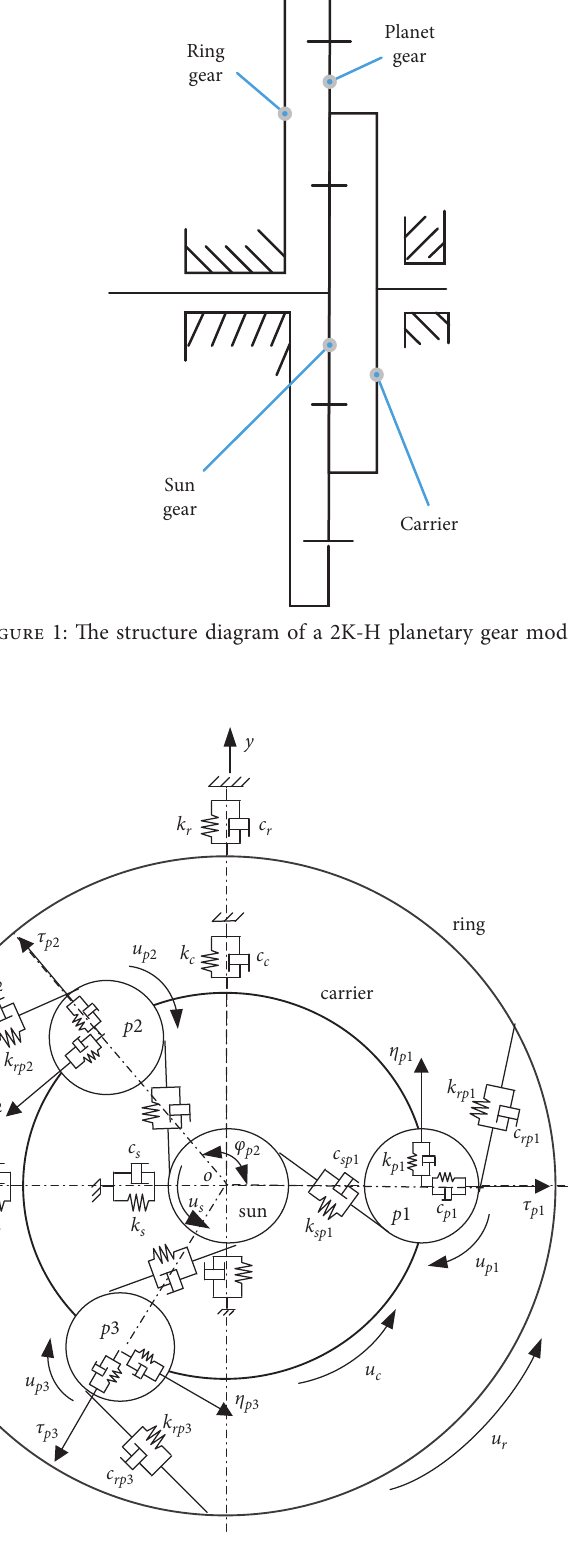
Figure 2: The dynamic model with three planet gears located at equal